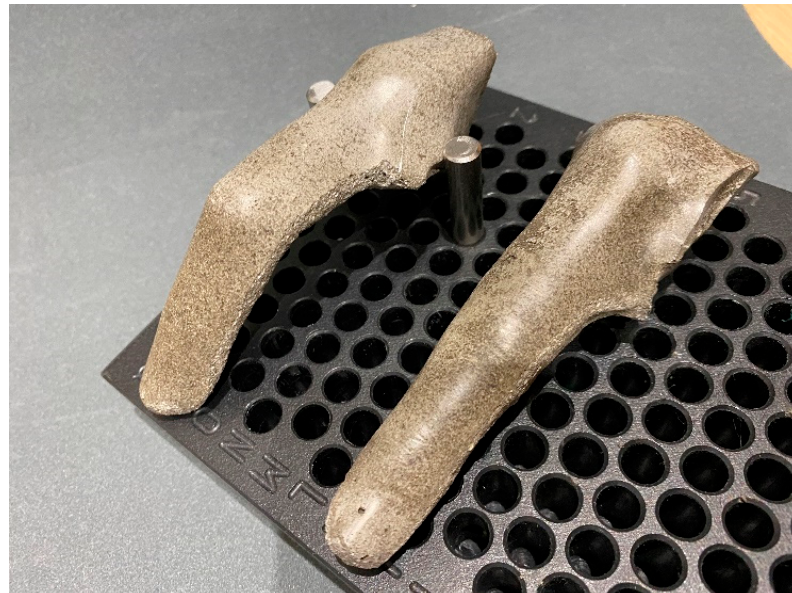
Figure 6. Concrete models.